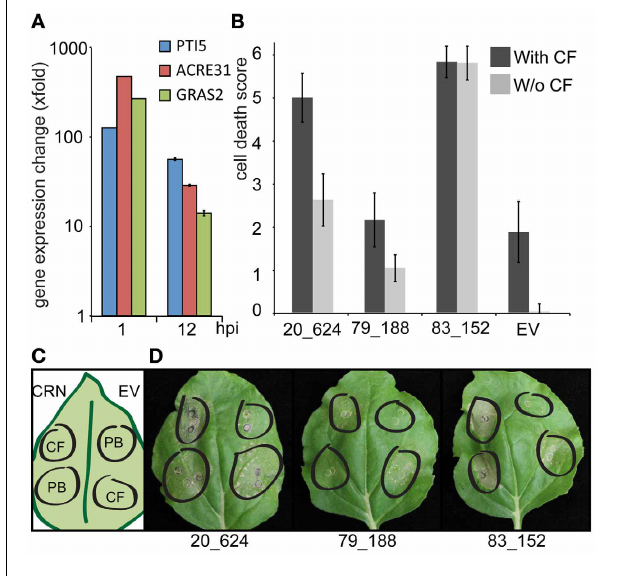
FIGURE 3 | Expression of CRN20_624, but not CRN79_188 and CRN83_152 has an additive effect on PAMP induced cell death. (A) qRT-PCR analyses on cDNA derived from leaf panels transiently expressing EGFP and treated with PB and CF. Each bar represents the fold change in gene expression upon CF treatment relative to PB ± standard deviation. Expression was examined for known PTI marker genes NbPti5 , NbAcre31 , and NbGras2 at 1 and 12h post infiltration (hpi). (B) Graph showing average necrosis scores ± standard deviation for three independent experiments. (C) Graphical representation of the experimental set-up. CRN-GFP fusion constructs were infiltrated into N. benthamiana plants and after 48h, leaves were infiltrated with either a PAMP cocktail ( Phytophthora capsici culture filtrate) or a control solution of pea broth. Cell death was scored on a scale of 0–6, 48h after CF treatment. (D) Examples of representative leaves for each treatment on day of scoring.